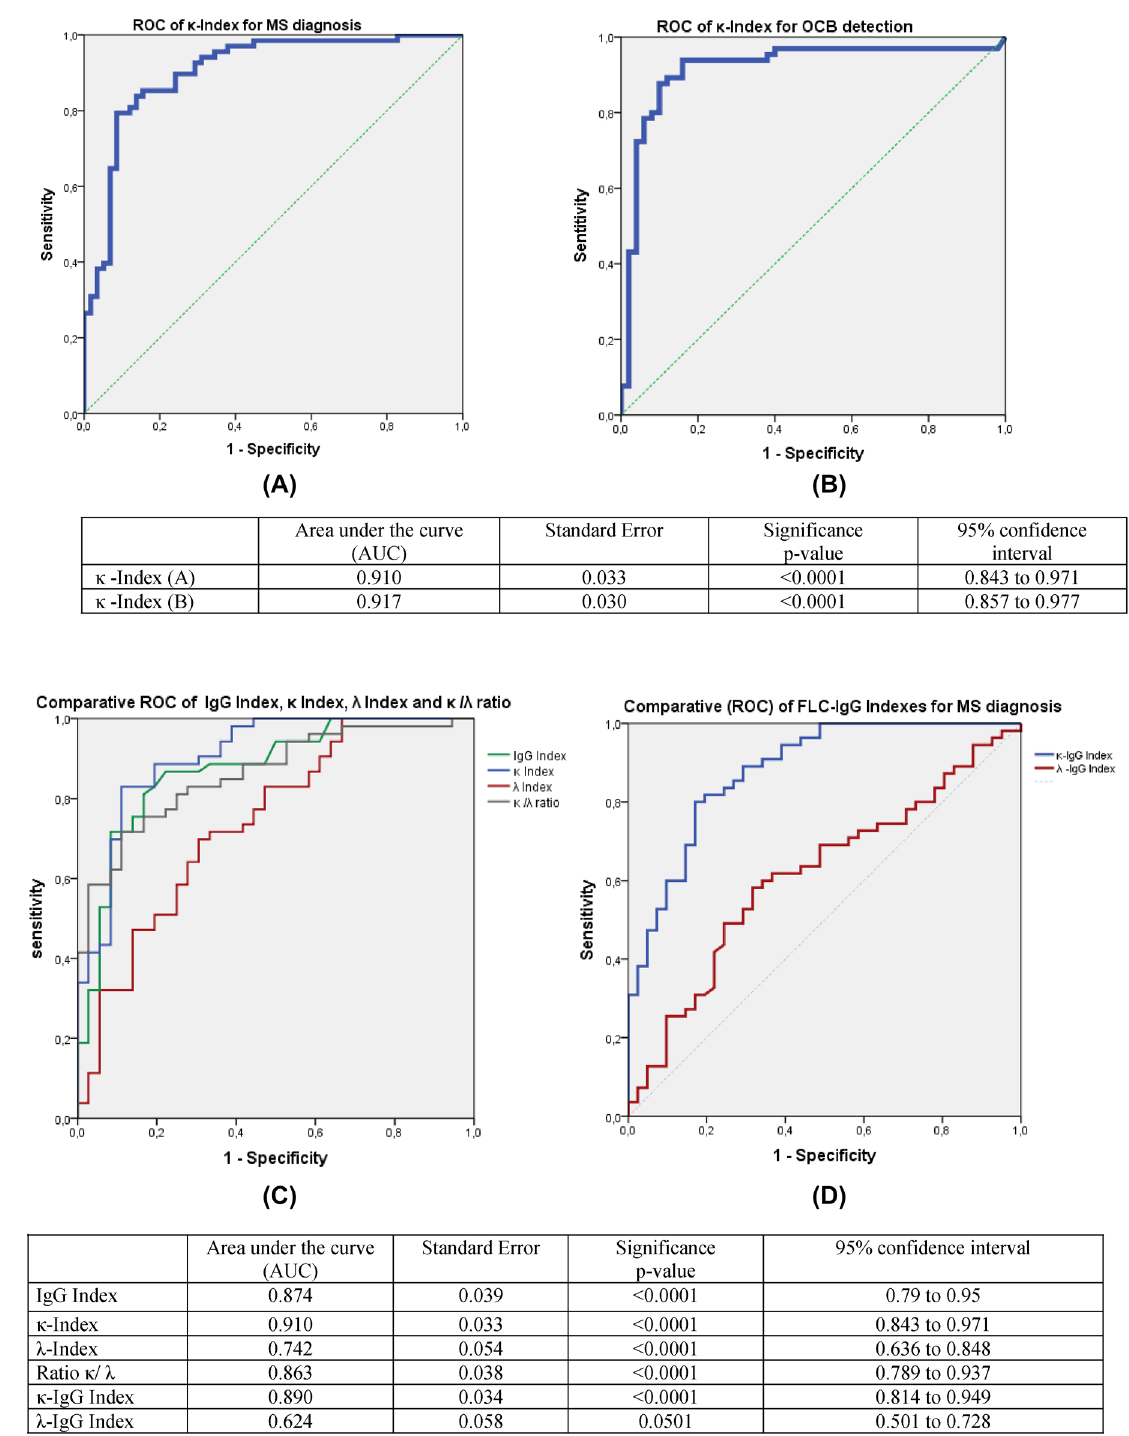
Figure 4. ( A ) ROC curve for the κ-index performance to discriminate MS patients from non-MS patients. ( B ) ROC curve for the κ-index performance to discriminate OCB-positive patients from OCB-negative patients. ( C ) Comparative ROC curves for IgG index, κ-index, λ-index, and κ/λ ratio to discriminate MS patients from non-MS patients. ( D ) Comparative ROC curves for κ-IgG index and λ-IgG index to discriminate MS patients from non-MS patients. ROC receiver operating characteristic, MS multiple sclerosis, OCB , oligoclonal